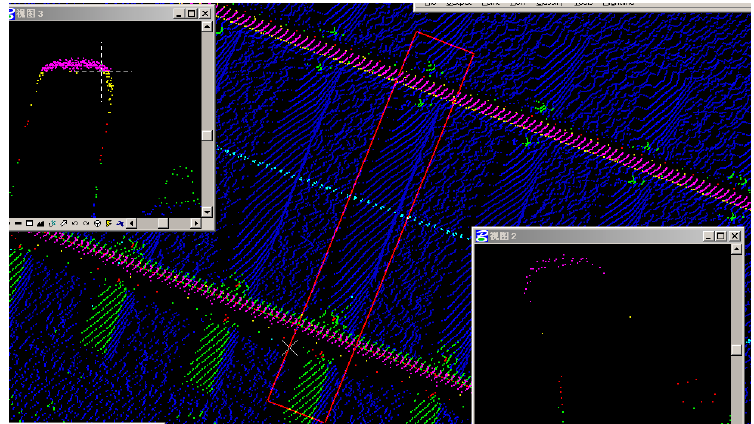
Figure 3. Extraction results of the railway midline. The purple represents the rail top area, the red is the rail side area, and the cyan area is the rail centerline.